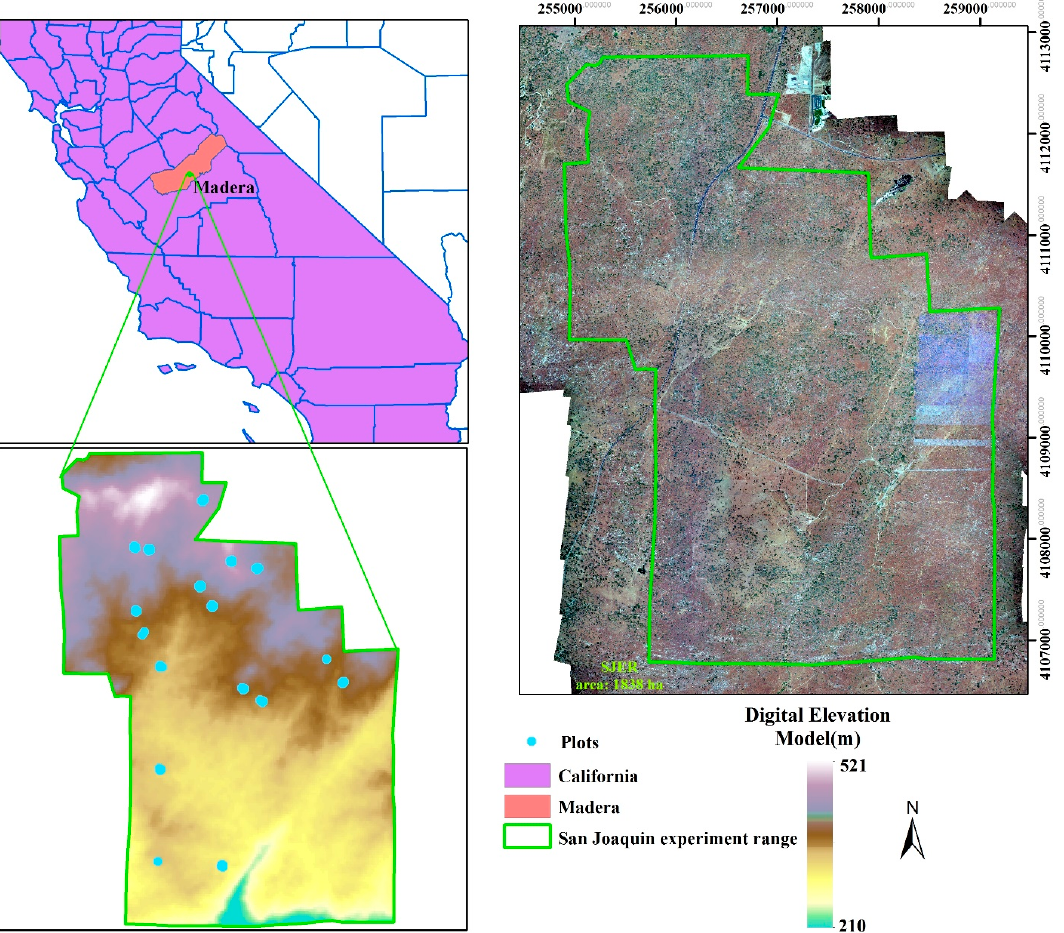
Figure 1. An overview of study area with filed-measured plots in the San Joaquin Experimental Range (SJER).